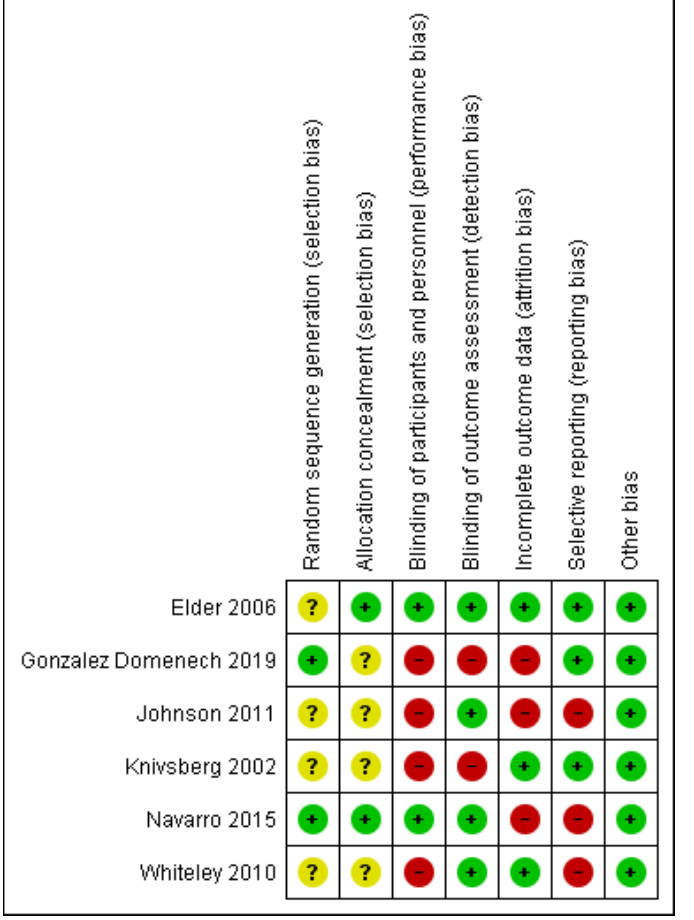
Figure 10. Risk of bias assessment as assessed by the Cochrane risk of bias tool. A plus (+) indicates a low risk of bias, a question mark (?) indicates an unclear risk of bias, and a minus ( − ) indicates a high risk of bias. The specific type of bias is presented in the top column and the individual studies in the left